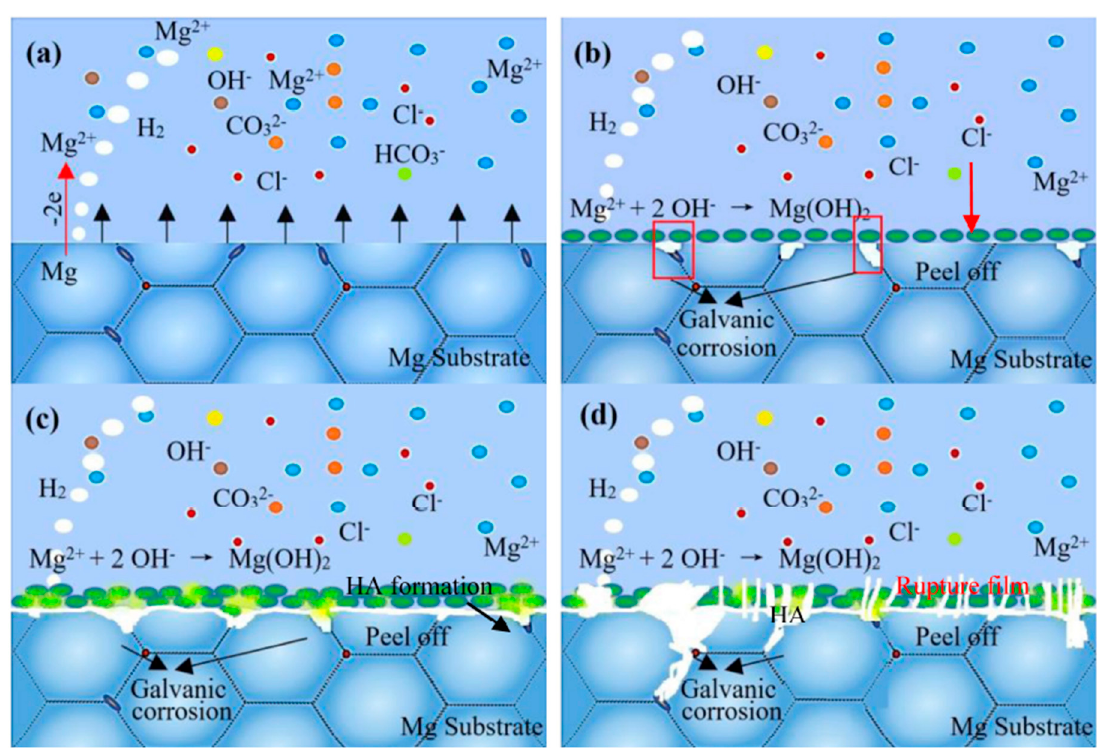
Figure 15. Schematic illustration of corrosion mechanism of as-studied alloys in the Kokubo solution.